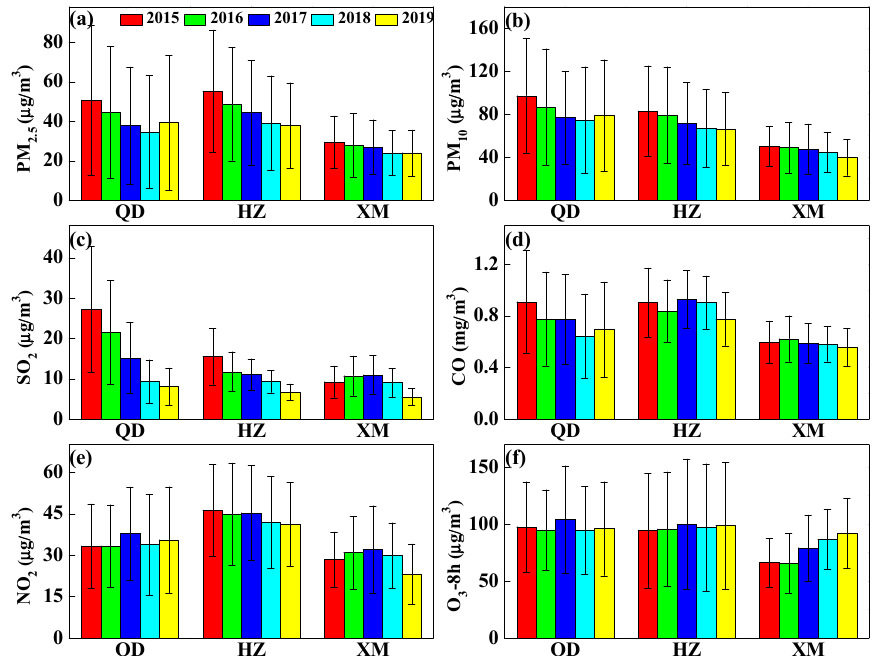
Figure 2. Inter-annual variations of PM 2.5 ( a ), PM 10 ( b ), SO 2 ( c ), CO ( d ), NO 2 ( e ), and 8 h peak O 3 ( f ). in Qingdao (QD), Hangzhou (HZ), and Xiamen (XM) during 2015–2019. The error bar represents standard deviation.